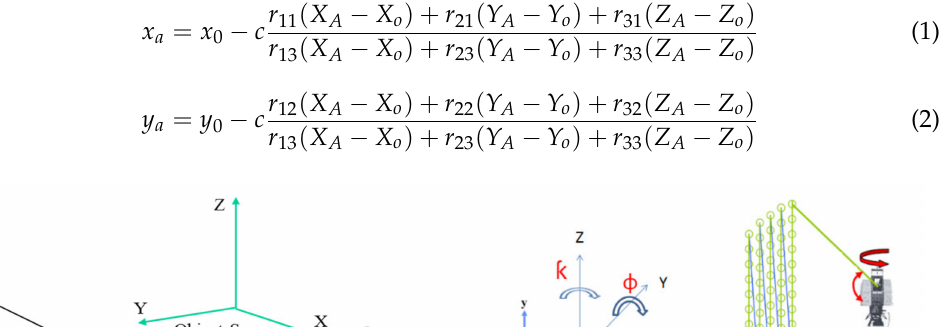
manual method entails defining conjugate pixel-model coordinates as input data and then solving camera resection using collinearity condition equations. As shown in Figure 21, these equations are derived from the central projection of an object point via the sensor plane to the camera’s perspective center (PC). The resulting parameters are represented by a 3 × 3 rotation matrix and a translation vector within the equations (Equation (1)). The image coordinates are (x a , y a ), while the object coordinates are (X A , Y A , Z A ). The rotation matrix elements rij are obtained from the angular parameters ( ω , F , Î ). (X 0 , Y 0 , Z 0 ) are the coordinates of the camera, c is the focal length of the camera, and (x 0 , y 0 ) are the principal point coordinates.